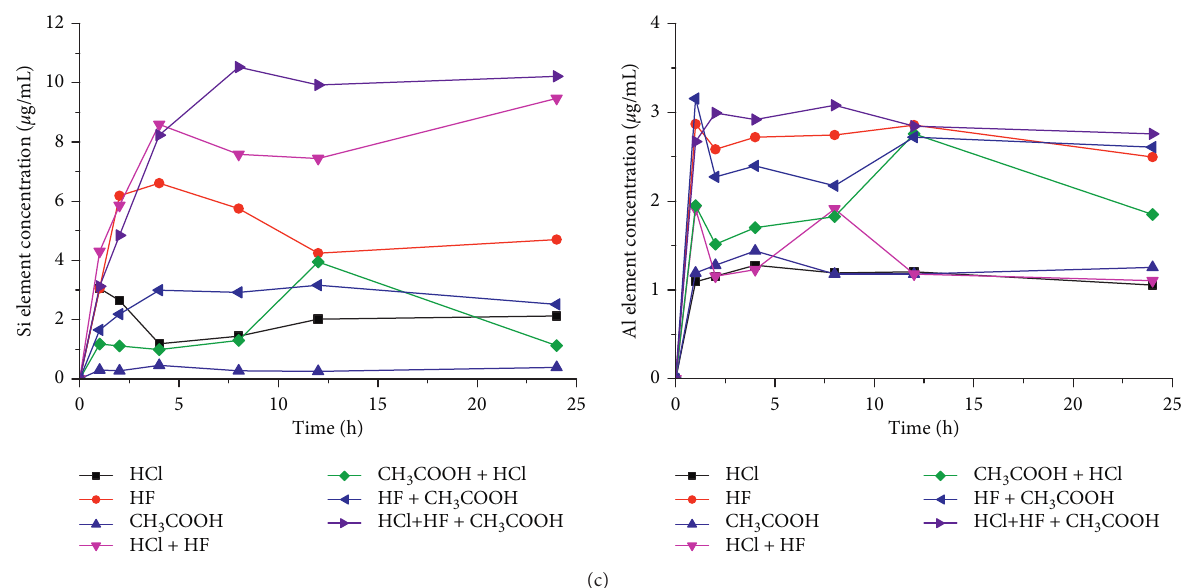
Figure 2: Variation of Si and Al elements with different concentrations of different acidified sodium bentonites overtime: (a) 5% acid Si and Al elements change with time; (b) 10% acid Si and Al elements change with time; (c) 15% acid Si and Al elements change with